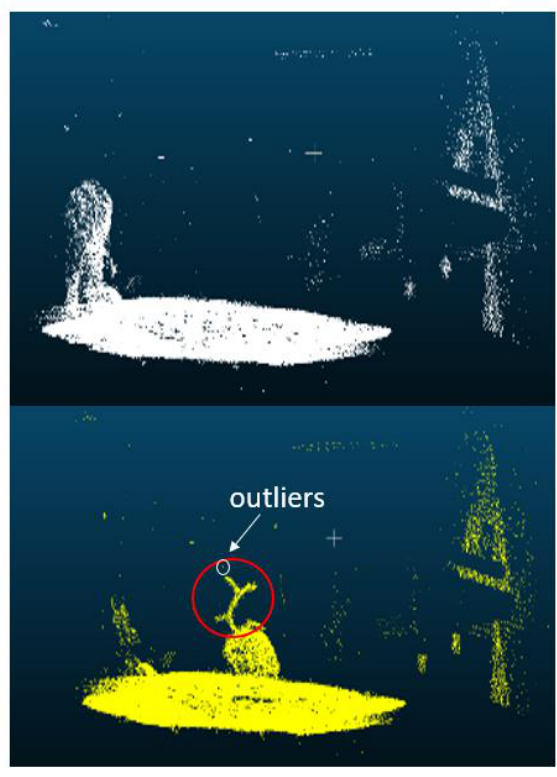
Figure 6. Base point cloud (up) and data point cloud (bottom).